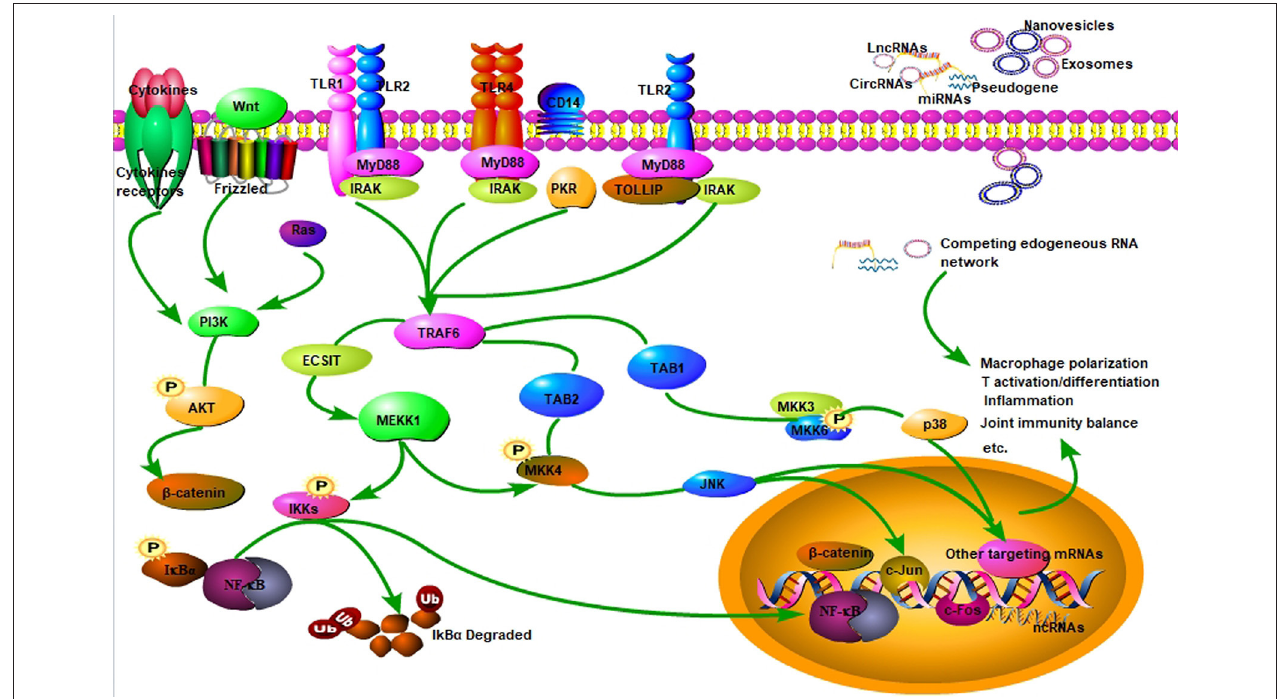
FIGURE 1 | Signaling pathway of ncRNAs in RA. NcRNAs (miRNA, lncRNA, circRNA) are involved in regulating inflammation and autoimmunity, such as immune cell activation, differentiation, and polarization. Some ncRNAs are encapsulated in nanovesicles and exert critical effects on inflammatory and immune cells, and some can function as ceRNA by sponging miRNAs in RA. NcRNAs participate in RA inflammation and autoimmune disorders primarily through TLR4/NF- κ B, MAPK/PI3K, and Wnt3a/ β -catenin signaling pathways, and so